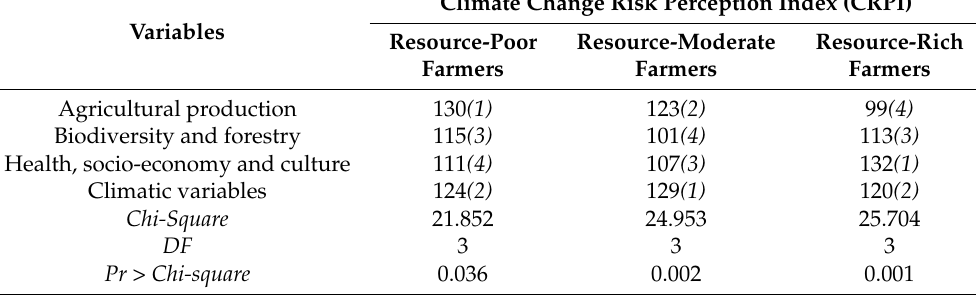
Table 7. Risk perception on impact variables by different wealth categories of farmers in Lawra district ( N =